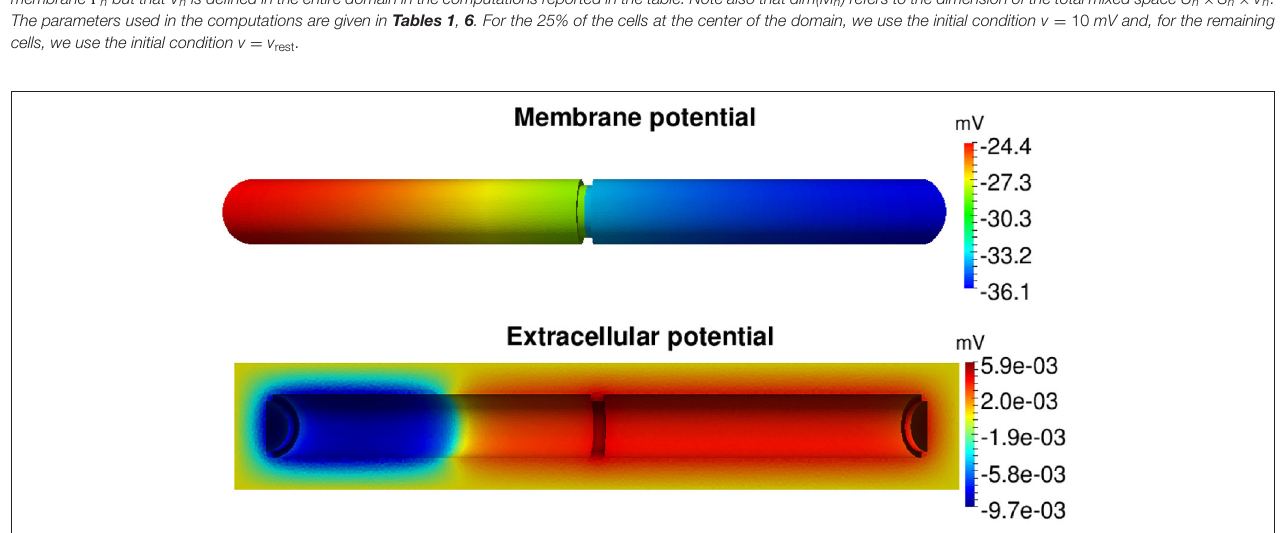
membrane using classical homogenized models. This is an important shortcoming of the classical methods, because a non- uniform distribution of sodium channels is believed to affect the conduction velocity. In the EMI modeling framework, the representation of non-uniform distributions of ion channels is straightforward.